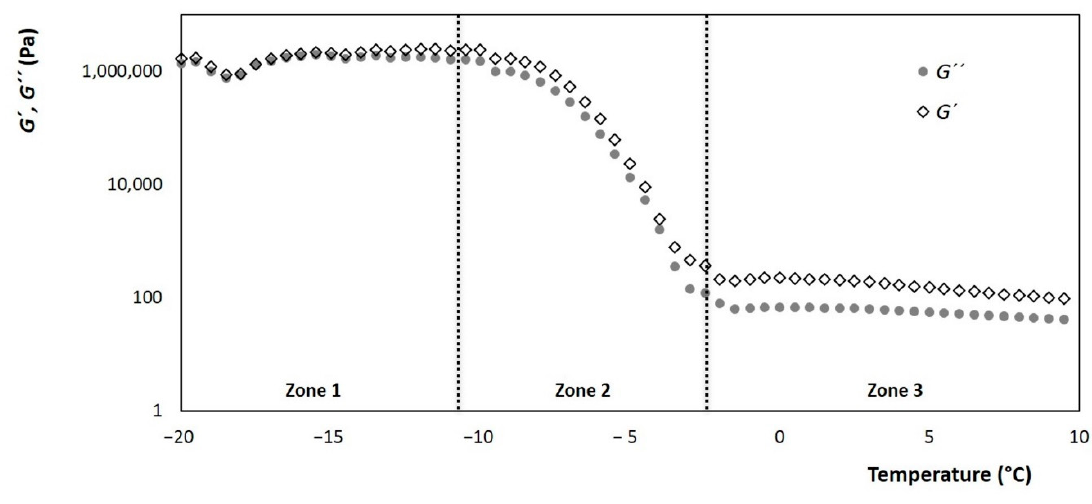
Figure 8. Evolution of the storage and loss modules (G’ and G” respectively) of ice cream, with respect to the change in temperature, with a constant frequency and shear rate of 68.93 s − 1 .